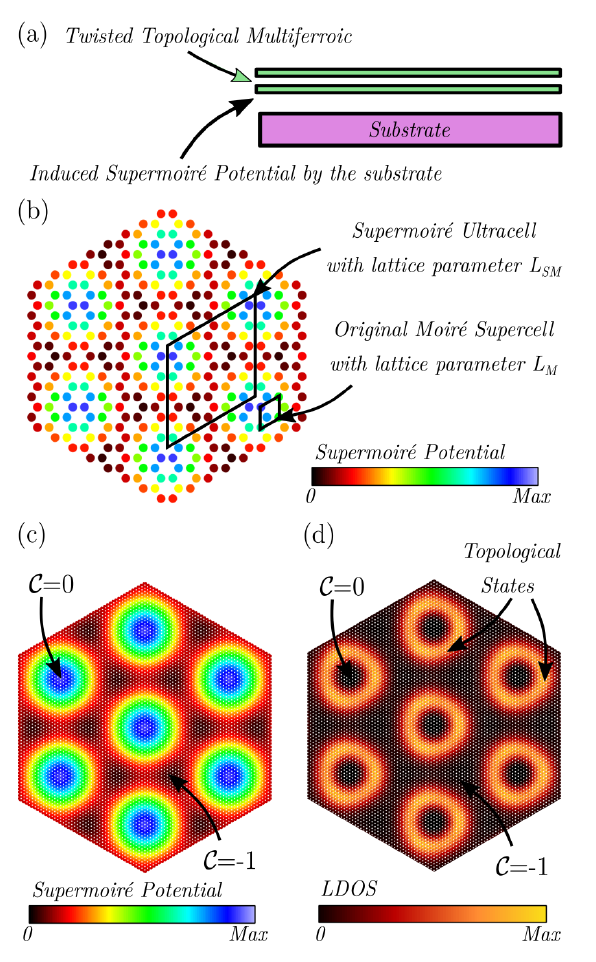
Figure 6: (a) Effect of a substrate on a twisted topological multiferroic. A super- moiré potential is induced in the twisted system by the substrate. (b) Sketch of the supermoiré potential on the staggered honeycomb lattice. The external field com- = 5 L mensurates with a 5 × 5 ultracell of the staggered honeycomb lattice, L . SM M = 30 L (c) Supermoiré potential of L used in the calculations. The electric po- SM M tential creates a modulation with different topological-charge regions, C = 0 on the maximum values of the potential and C = − 1 for the minimum values. (d) Local = 30 L density of states (LDOS) at zero energy for the L supermoiré potential SM M shown in panel (c). Circular topological states emerge at the boundaries of regions with different topological invariant, i.e, inside and outside of the emergent